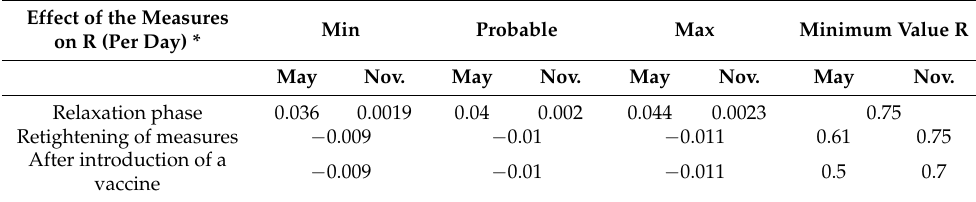
Table A4. Uncertain effect of the measures used for the forecast on R or on the costs. Effect of the Measures on R (Per Day) *